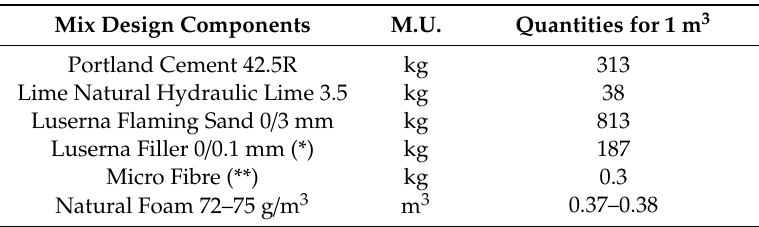
Table 4. Eco-mortar for plaster mix design with Luserna sawing sludge. Components and quantities for 1 m 3 . (*) filler from Luserna sawing sludge particle size distribution 0/300 µm; (**) polypropylene synthetic fibres = 6–12 mm.